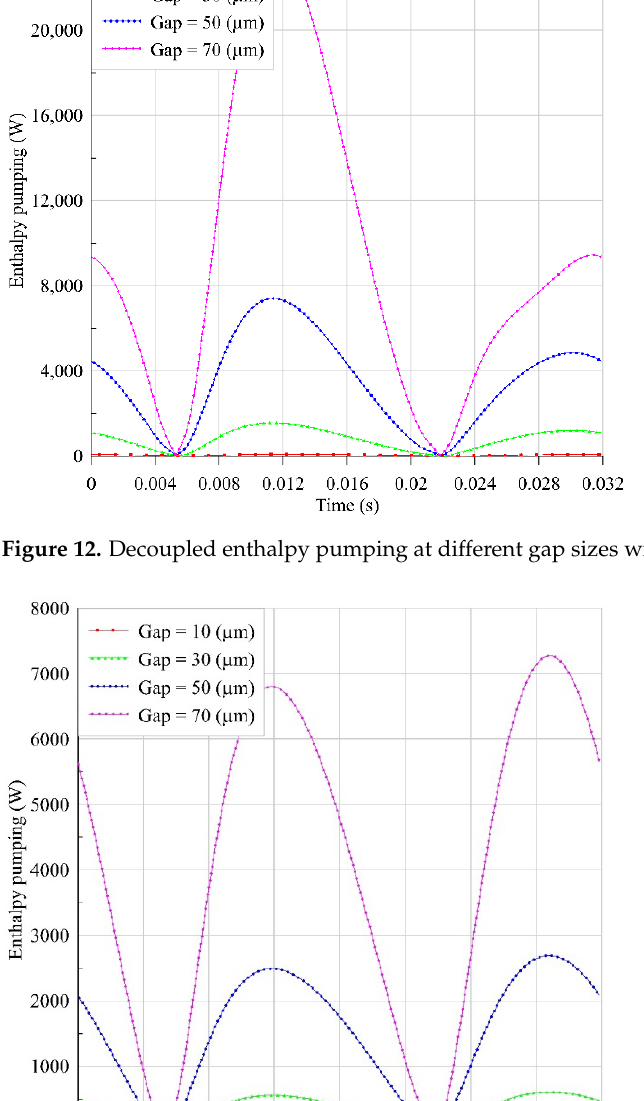
. . Figure 13. Decoupled enthalpy pumping at different gap sizes with T e − T c 𝑇𝑇 𝑒𝑒 − 𝑇𝑇 𝑐𝑐 𝑇𝑇 𝑒𝑒 − 𝑇𝑇 𝑐𝑐